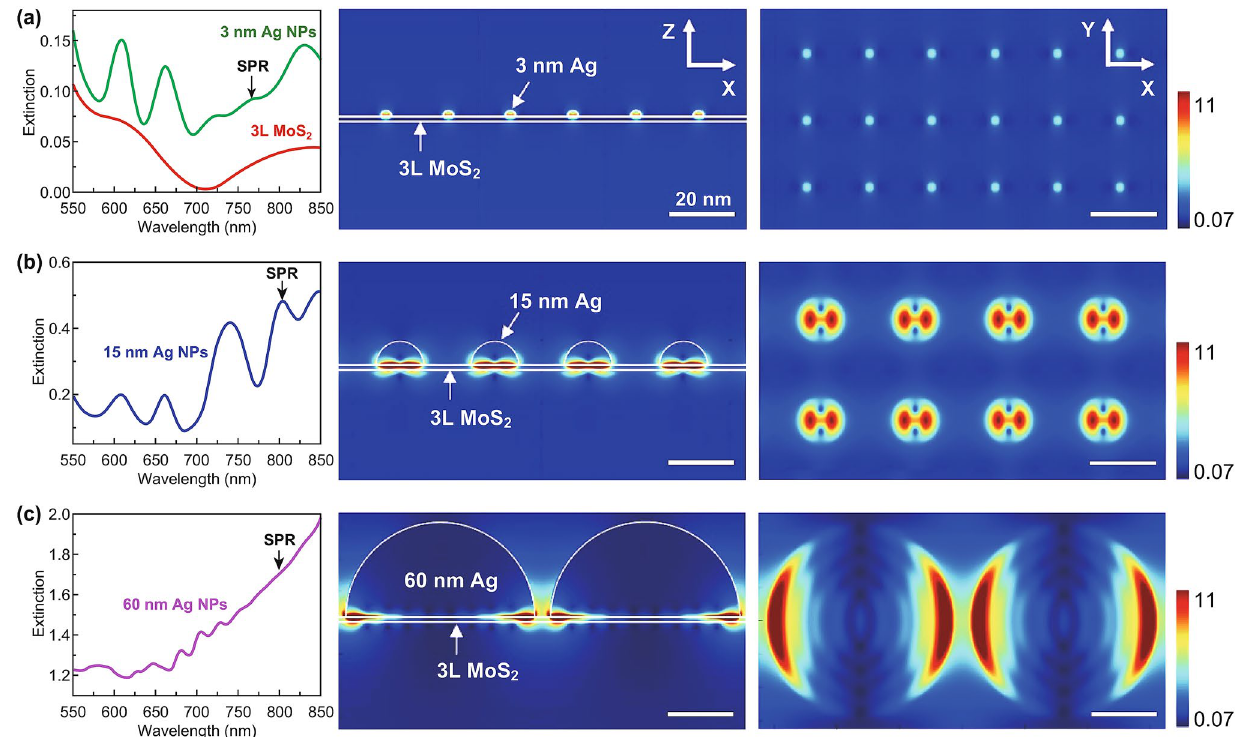
Fig. 6 Simulated UV–Vis absorption spectra and electric field distribution contour plots at λ SPR for a AgNP‑3, b AgNP‑15, and c